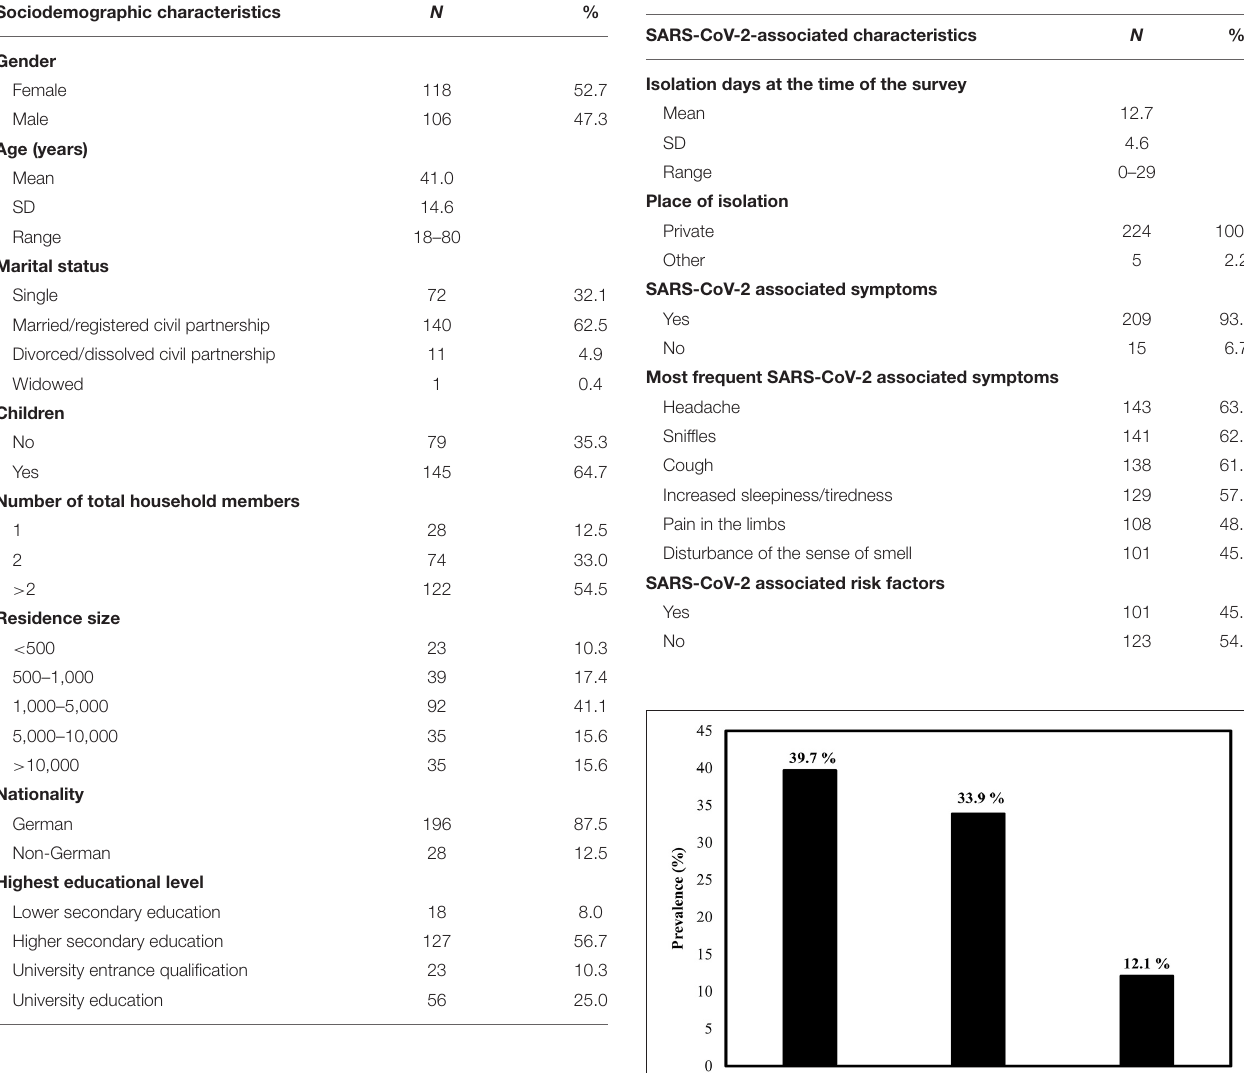
= 10.0, U = 3,514.0, z = − 5.6, p < 0.001, and r = 0.4). The severity of disease on the worst day of illness was significantly